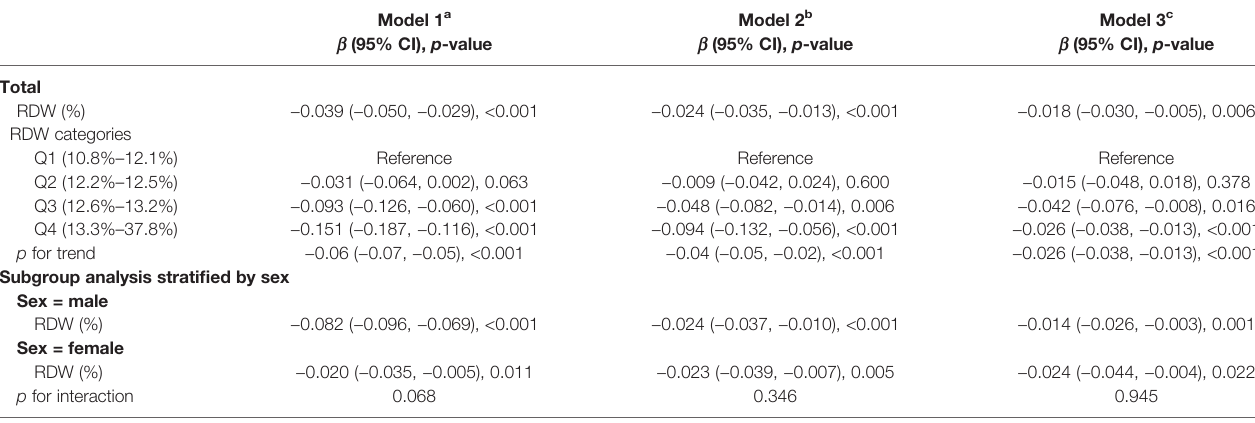
a Model 1: no covariates were adjusted. b Model 2: age, gender, and race/ethnicity were adjusted. c Model 3:age, gender, race/ethnicity,education, poverty-to-income ratio, meanarterialpressure, bodymassindex,alcohol use,smoke, cancer, coronary heart disease,congestive heart failure, angina pectoris, hemoglobin, mean corpusular volume, total cholesterol, high-density lipoprotein cholesterol, serum albumin, serum iron, blood urea nitrogen, serum cotinine, estimated glomerular fi ltration rate, C-reactive protein, and urine iodine were adjusted. In the subgroup analysis strati fi ed by sex, the model was not adjusted for sex. RDW, red blood cell distribution width; fT3, free triiodothyronine; CI, con fi dence